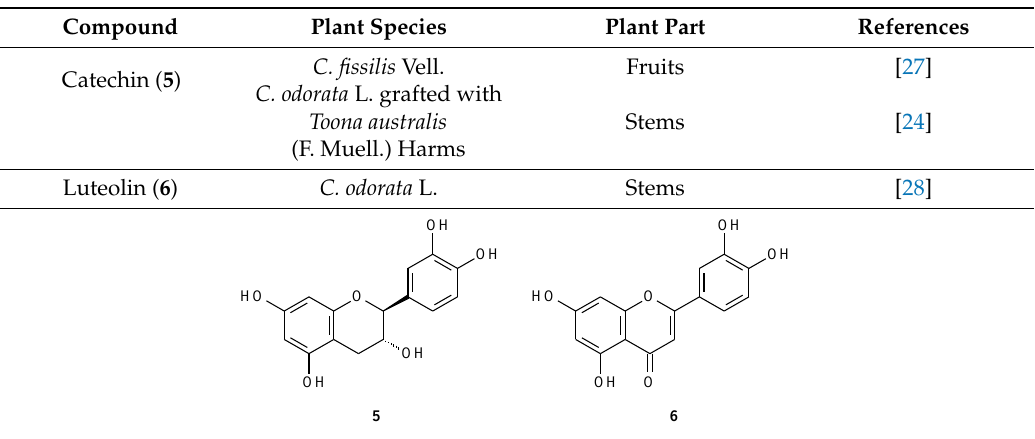
Table 2. Flavonoids isolated from the genus Cedrela (1960–2020).